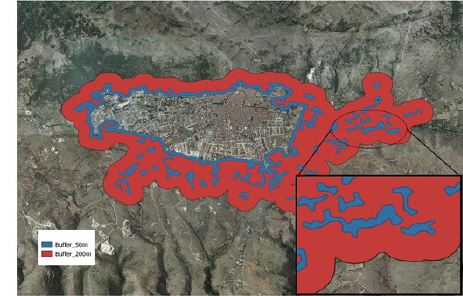
Figure 5 . Final result of defining the perimeter strip (Buffer 200m in red) and the interface strip (Buffer 50m in blue).